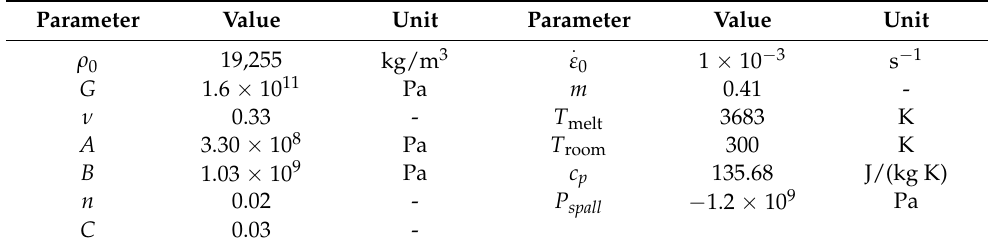
Table 1. J–C parameters for tungsten [59].